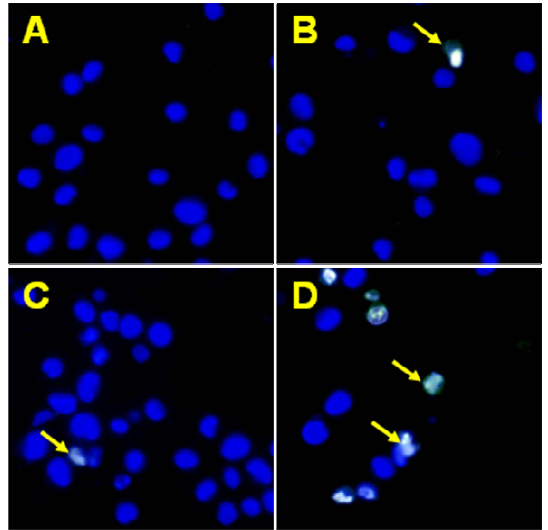
Figure 8. TRAIL in combination with chalcone induced apoptosis in LNCaP prostate cancer cells. The cancer cells were incubated for 48 hours with TRAIL at the concentration of 100 ng/mL and chalcone at the concentration of 100 μ M. Detection of apoptotic cell death by annexin V-FITC staining using fluorescent microscopy. The healthy cells (stained with Hoechst 33342) emitted blue fluorescence and apoptotic cells. Apoptotic cells (stained with Annexin V-FITC and Hoechst 33342) emitted green and blue fluorescence (indicated by arrows). (A) Control cells, (B) cells incubated with TRAIL (100 ng/mL), (C) cells incubated with chalcone (100 μ M), (D) cells incubated with TRAIL (100 ng/mL) and chalcone (100 μ